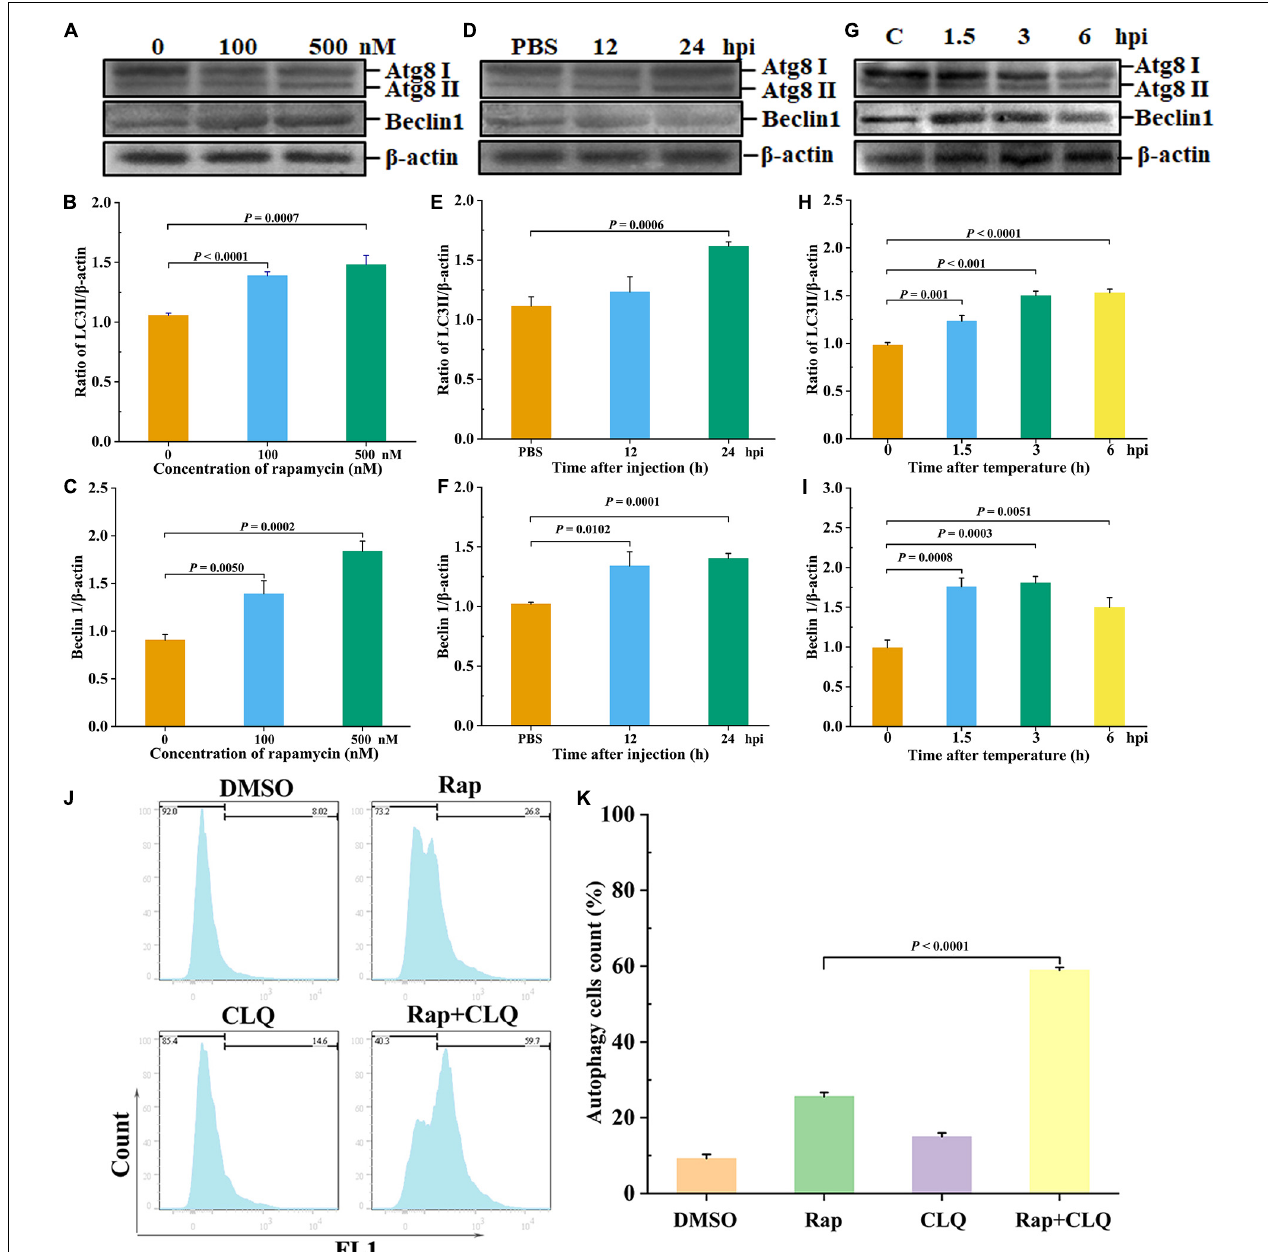
FIGURE 4 | Low temperature induced autophagy in vivo . Shrimp were injected with rapamycin at different concentrations. At 12 and 24 h after rapamycin injection, the shrimp hepatopancreas specimens was collected for Western blot analysis with an LC3 and beclin1 antibody. Dosage of rapamycin for autophagy induction Western blot analysis (A) , LC3 (B) , and beclin1 (C) statistical analysis. Time-course detections of autophagy Western blot analysis (D) , LC3 (E) , and beclin1 (F) statistical analysis. Low-temperature stress induction for autophagy Western blot analysis (G) , LC3 (H) , and beclin1 (I) statistical analysis. The ratios of LC3II/ β -actin and beclin1/ β -actin gray-scale value were calculated with three independent experiments. Shrimp primary hemolymph cells were treated with DMSO, 2 µ M rapamycin (Rap), 8 µ M chloroquine (CLQ), or Rap + CLQ for 24 h to induce autophagy and then used CYTO-ID R (cid:13) Green Detection Reagent 2 stain for 30 min and analyzed by flow cytometry (J) and statistical analysis (K) . Data were shown as fold changes and mean ±